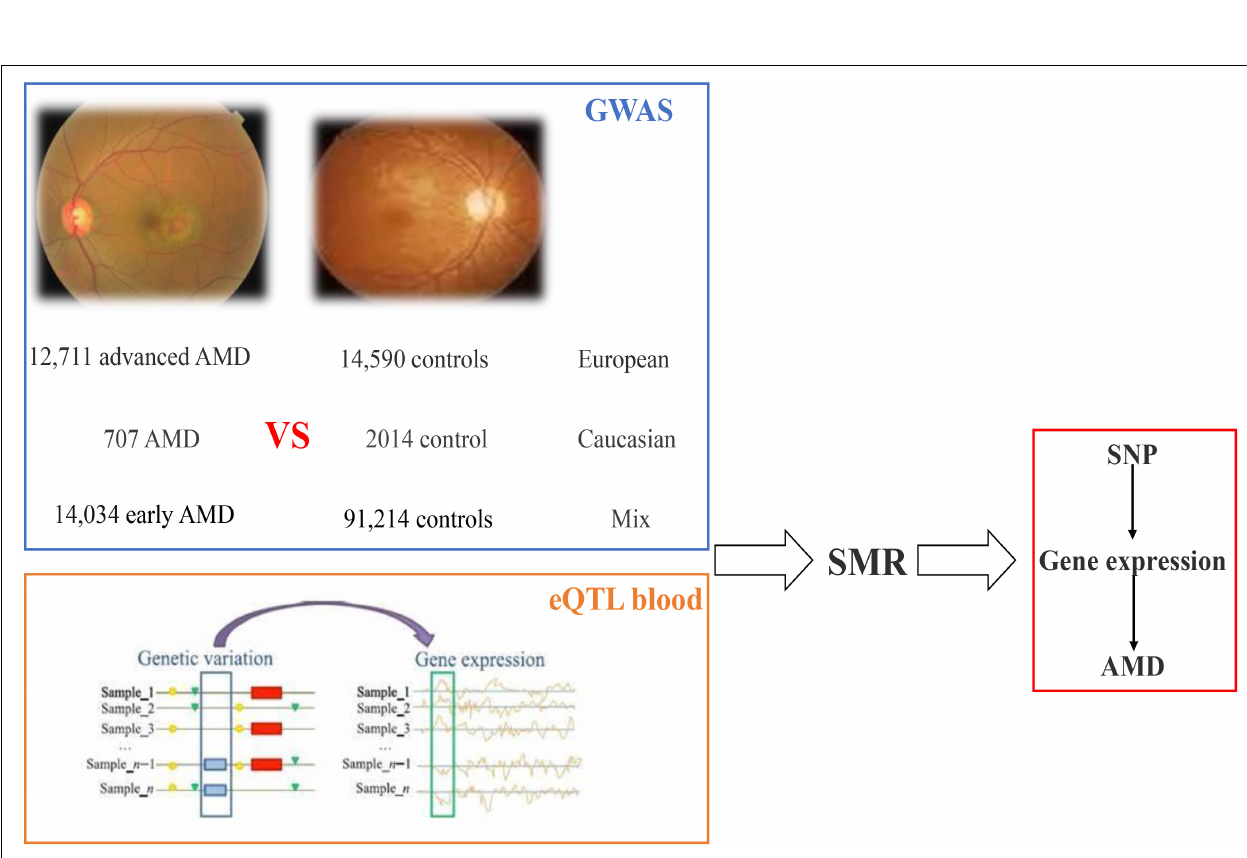
FIGURE 3 | (A,B) Distribution of GWAS summary dataset and blood eQTL dataset. GWAS, genome-wide association studies; eQTL, expression quantitative trait locus.